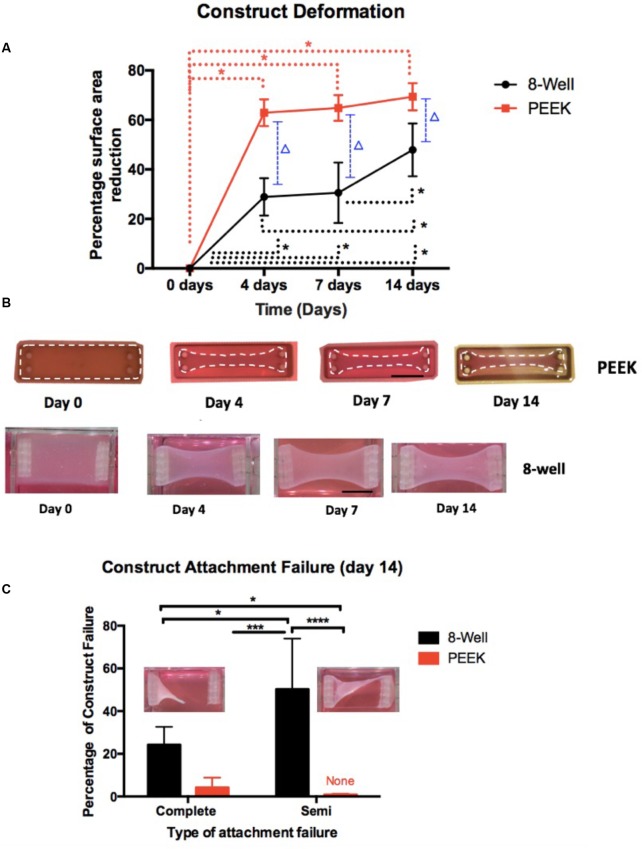
Construct deformation (percentage of construct surface area reduction) over time (a maximum of 14 days) and percentage of attachment failure.(A) Construct deformation shows the area of construct reduction over the course of the experiment at key intervals (0, 4, 7, and 14 days). The dotted lines with an asterisk show the link between the time intervals that have significance (p-value < 0.05) within the chamber type. The dotted line with a triangle (p-value < 0.0001) across the chamber types. (B) Macroscopic images of the constructs at days 0, 4, 7, and 14 showing the constructs deformation over the course of the experimental time frame. The upper images are of PEEK constructs that have been enhanced by outlining the constructs to define their contrast within their chamber against the surrounding medium. The lower row images are of the 8WC. Scale bar = 10 mm. (C) Attachment failure shows that 8WC has the highest construct failure for both complete and semi-failure, and the image inserts depict attachment failures. For panel (C) significance at ∗P < 0.05, ∗∗∗P = 0.0002, ∗∗∗∗P < 0.0001.